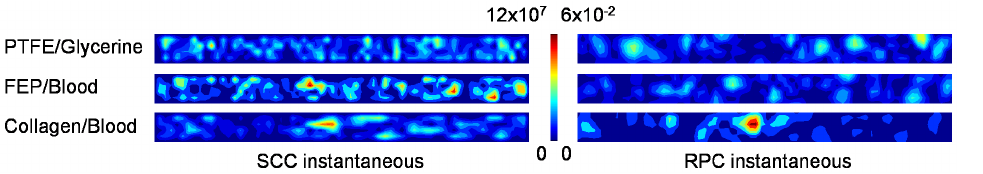
Figure 7. Contours of SCC and RPC correlation planes. The contour indicates relative correlation magnitude. Only the central 50% window is shown for RPC correlation planes.